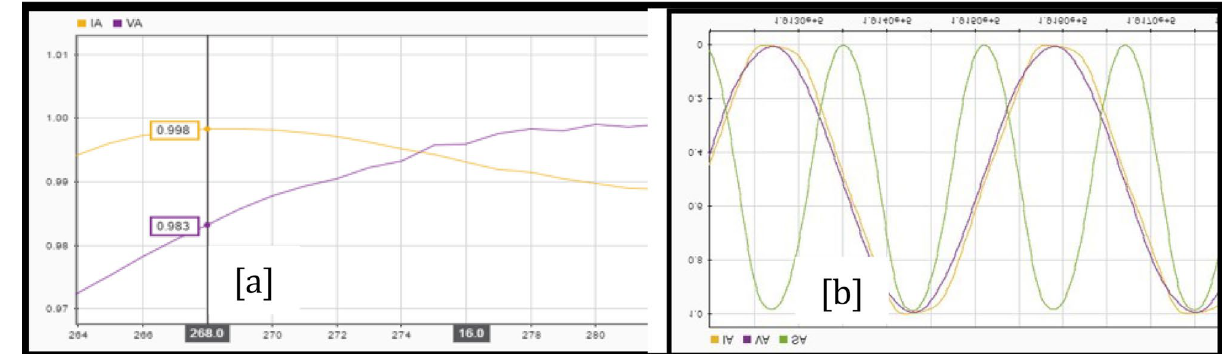
Figure 21. Policentro Instant power at the output ( a ) and RMS values of active demand power ( b ).